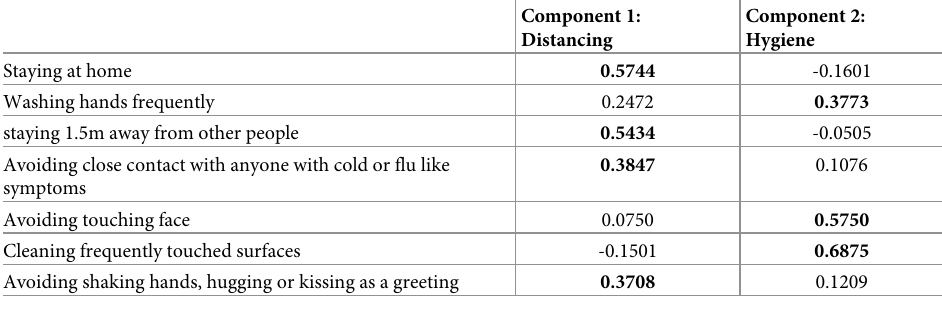
Table 4. Rotated component loadings from PCA for COVID prevention behaviours at baseline (April